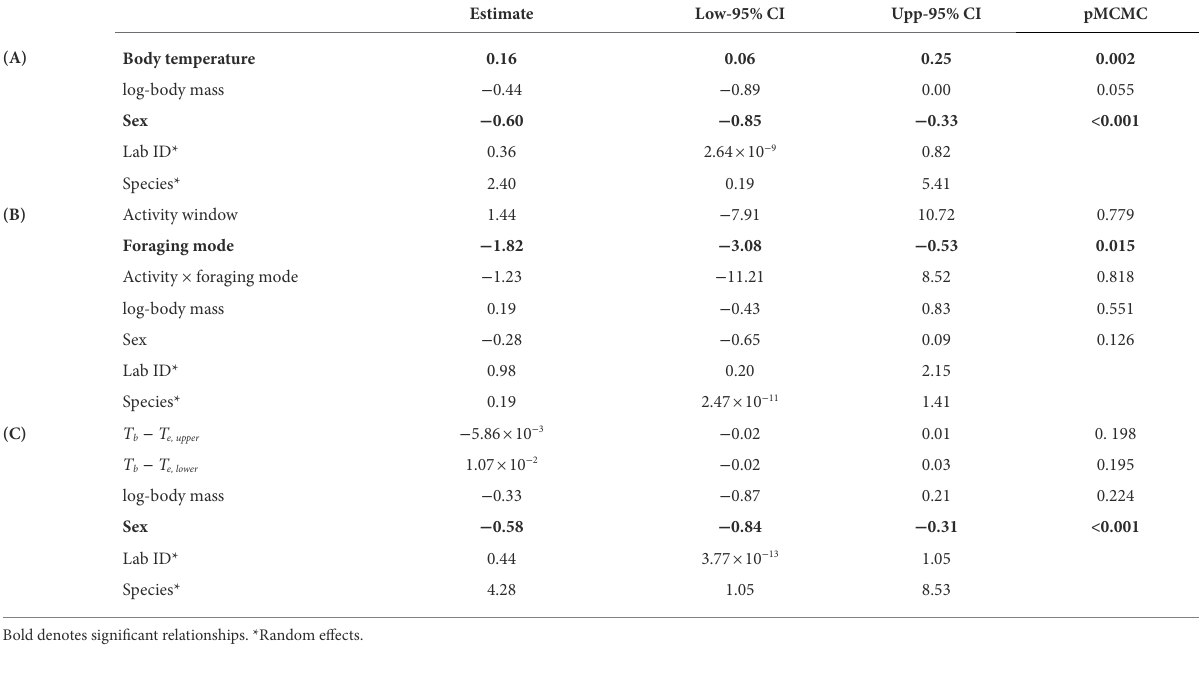
TABLE 1 Results of the three phylogenetic linear mixed-effect models testing the effect of body temperature (A), foraging mode and activity (B), and experienced temperature extremes (C) of glucocorticoid concentrations across lizard species.